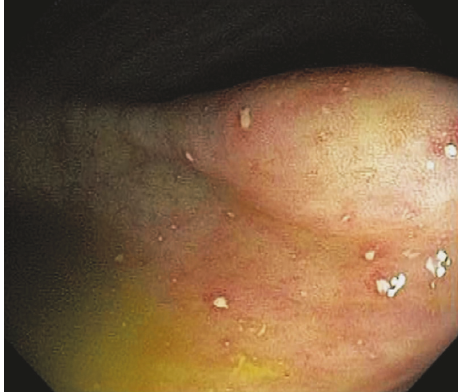
Figure 27: Computer tomographic image of typhlitis showing wall thickening involving the ileocecum and ascending colon, colon distention, and pneumatosis coli.